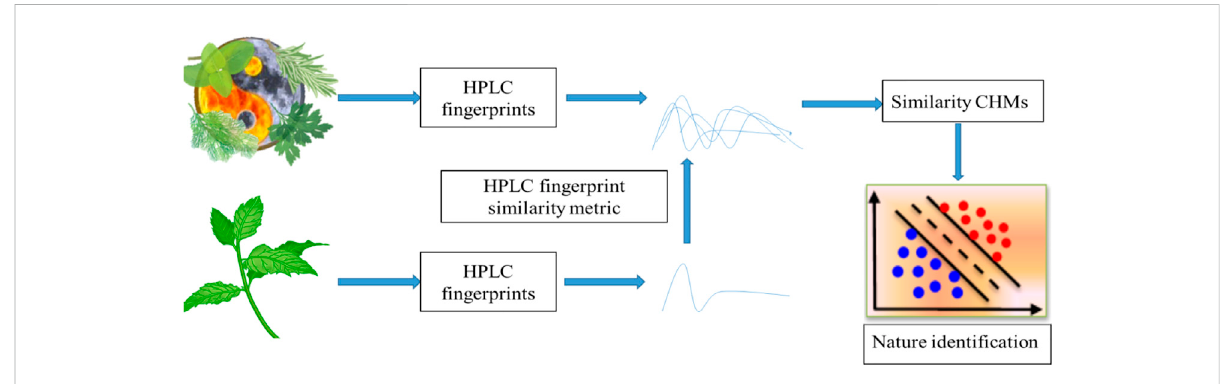
FIGURE 1 The cold-hot nature identi fi cation scheme